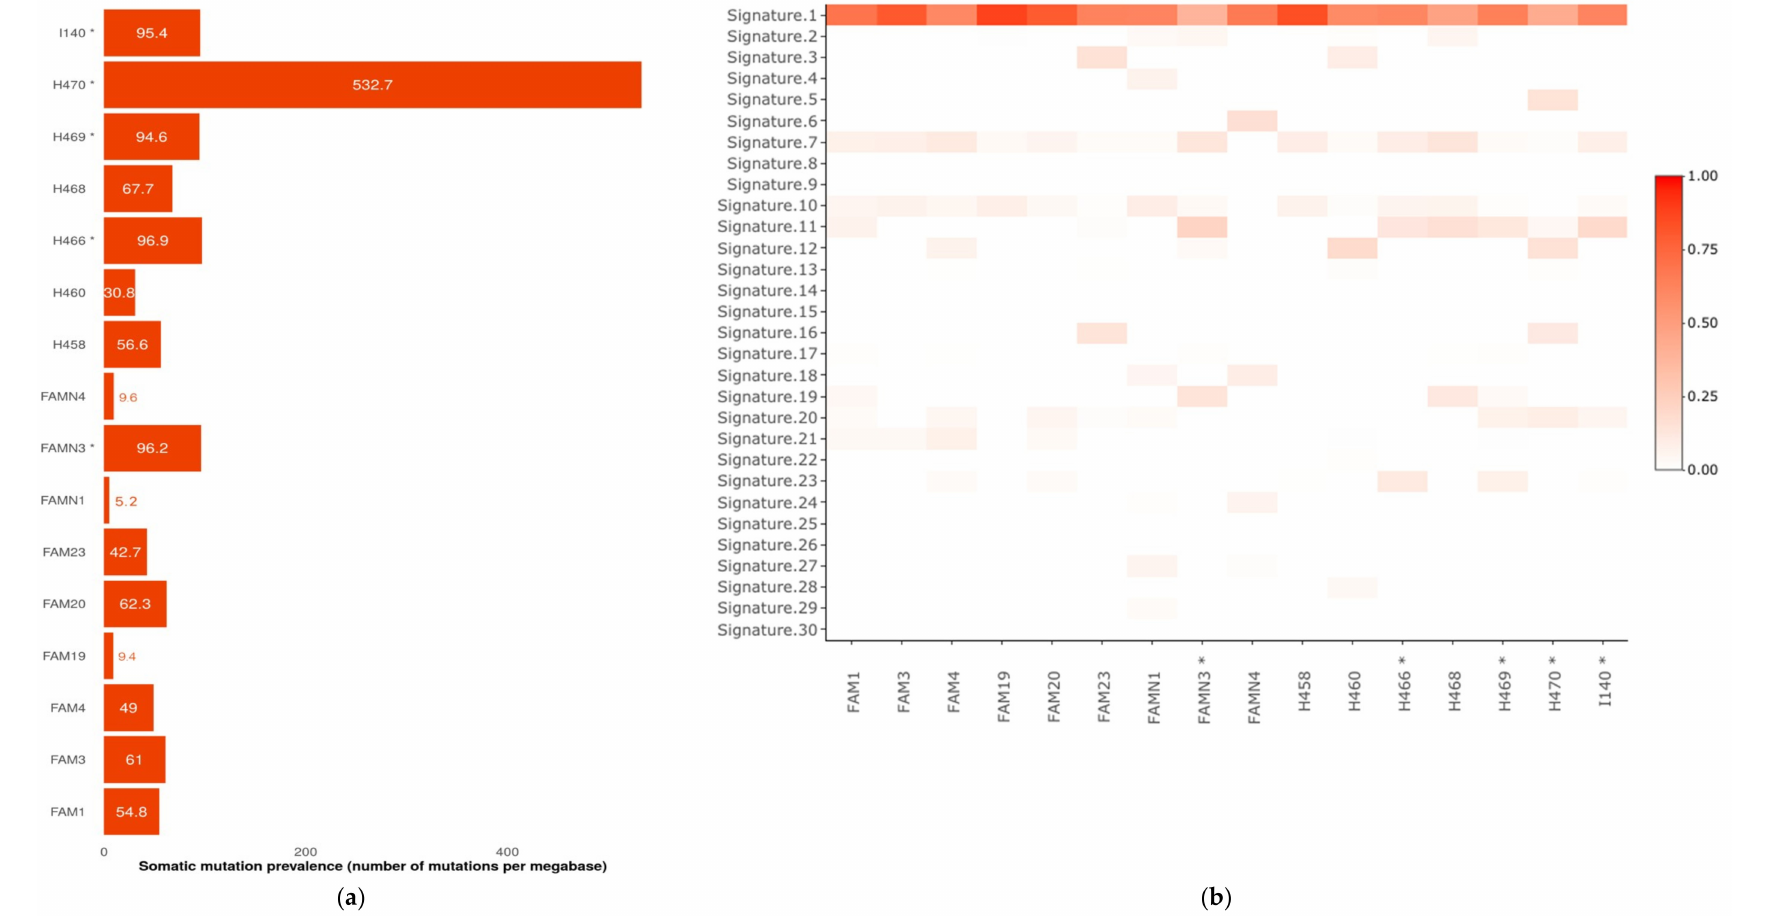
Figure 1. Somatic mutational profile analysis performed with the Mutational Signatures in Cancer (MuSiCa) tool in 16 germline–tumor paired samples. ( a ) Mutational prevalence (number of mutations per sequenced Mb). Hypermutated samples ( ≥ 90 mutations/Mb) are marked with an asterisk (*); ( b ) mutational signature refitting analysis showing the contributions of the 30 Catalogue of Somatic Mutations in Cancer (COSMIC) reference mutational signatures in the mutational catalogues of the samples of the